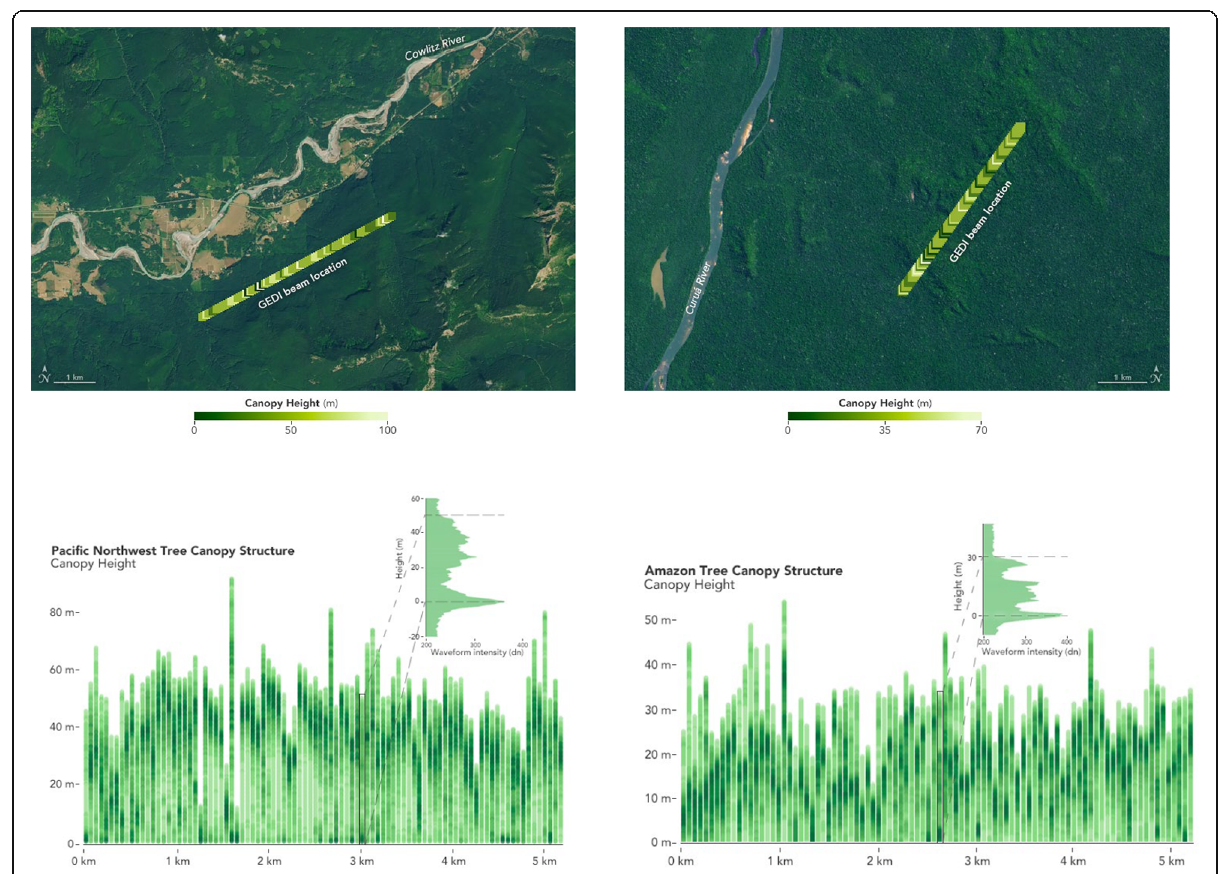
Fig. 22 The upper panels show a strip of early GEDI data superimposed over true color Landsat-8 images, from July 29, 2019, for the Cowlitz River on the left and August 9, 2019, for the Curuá River on the right. The left panels are located over conifer forests in the Coast Range of southwestern Washington, USA, along the Cowlitz River, a tributary draining into the Columbia River, and (right) over the rainforest of Brazil, along the Curuá River, a small tributary of the eastern Amazon in the State of Para. (NASA.gov Credits: NASA Earth Observatory / Lauren